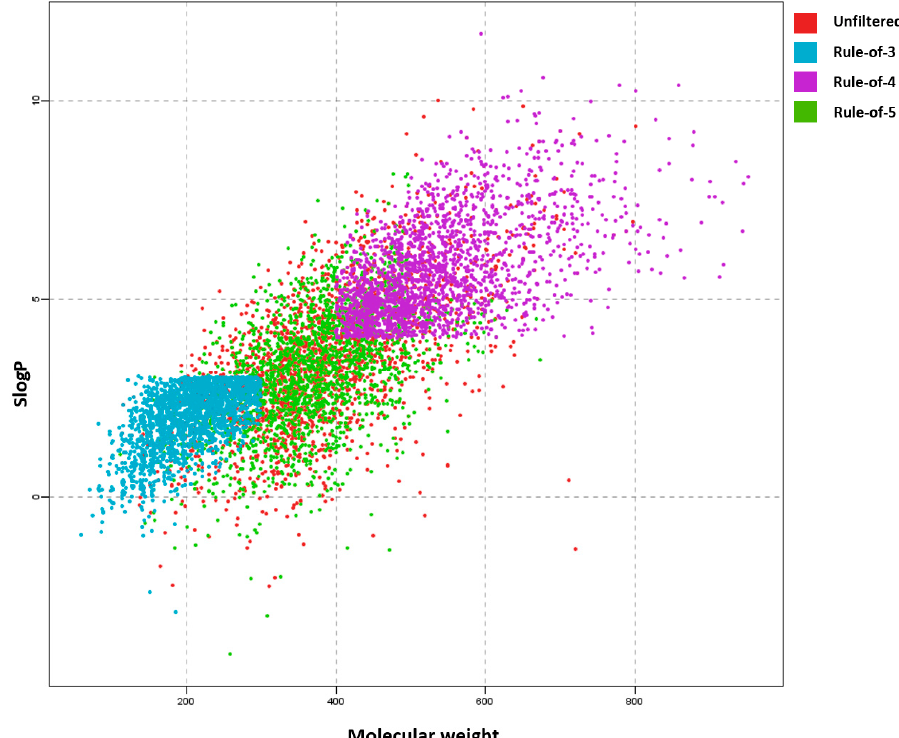
Figure 5. A 2D scatter plot of SlogP and molecular weight for compounds that passed individual filters. We can see the impact of using filters on the chemical space as the Rule-of-3 (blue) is totally separated from the Rule-of-4 (purple) group. This is due to the strict molecular weight cut-off and the SlogP cut-off as we see horizontal and vertical lines indicating where the cut-offs are. Since Lipinski’s Rule-of-5 (green) allows one rule break per compound, we do not observe such strict horizontal lines and the chemical space after filtering is still very similar to the unfiltered (red) library.